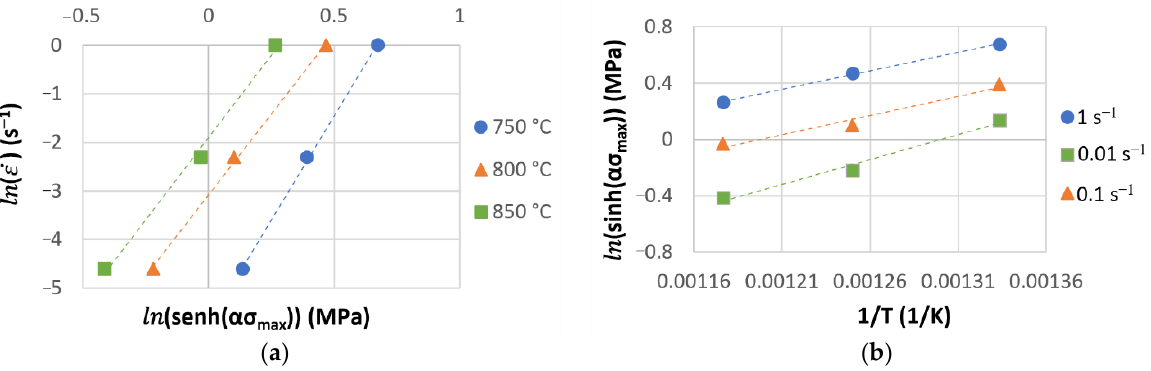
Figure 13. ( a ) Relationship at different temperature between 𝑙𝑛 (𝜀̇) and 𝑙 𝑛(𝑠𝑖𝑛ℎ(𝛼𝜎 𝑚𝑎𝑥 )). ( b ) Rela- tionship at different strain rates between 𝑙𝑛 (𝑠𝑖𝑛ℎ(𝛼𝜎 𝑚𝑎𝑥 )) and 1